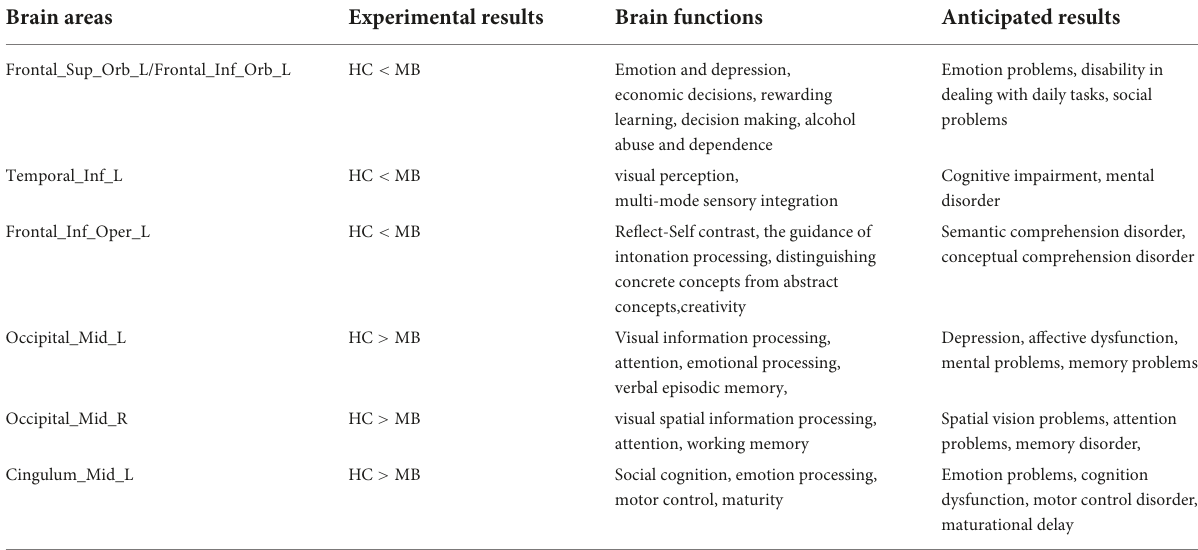
TABLE 3 PerAF method applied in ophthalmologic and neurogenic